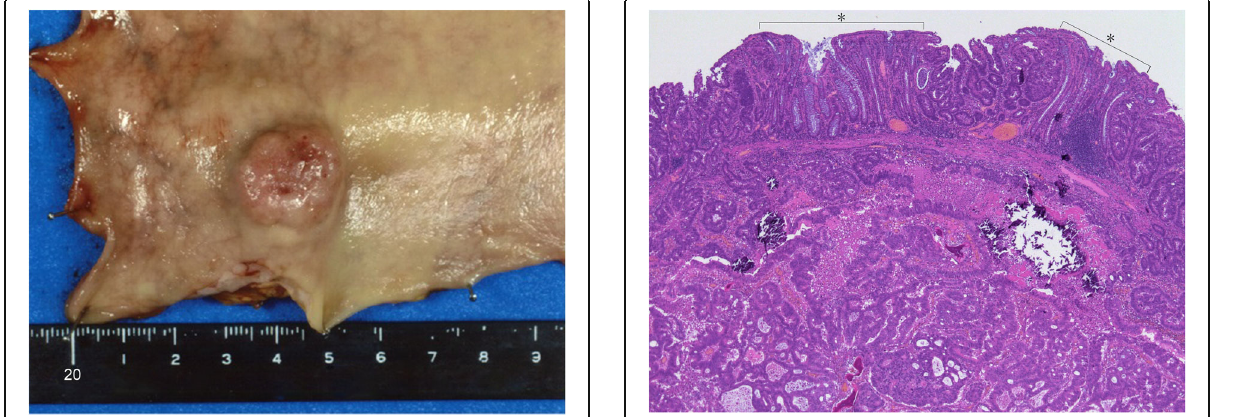
Fig. 4 Macroscopic findings from resected rectal specimens. The